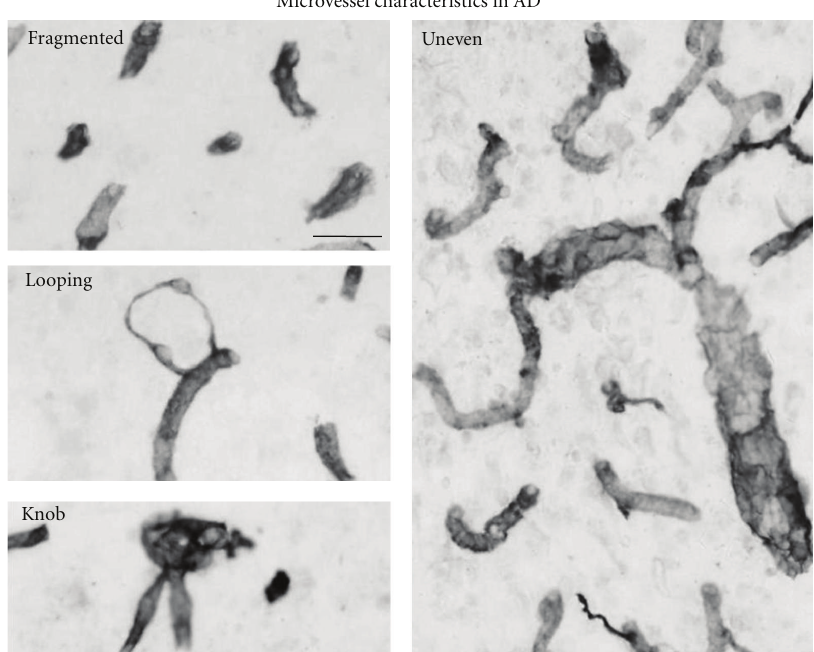
Figure 5: Physical and morphological properties of microvessels in AD brain tissue. The panels show microvessels with fragments, looping pattern, knob-like structure, and uneven structure. The scale bar is for 30 μ